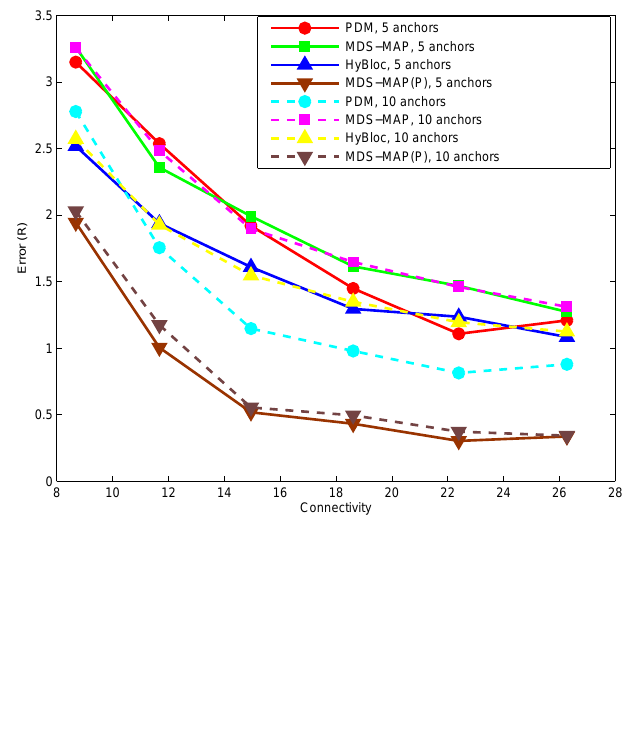
Figure 11 . Clustered anchors, α = 0.1, C-shaped Networks.